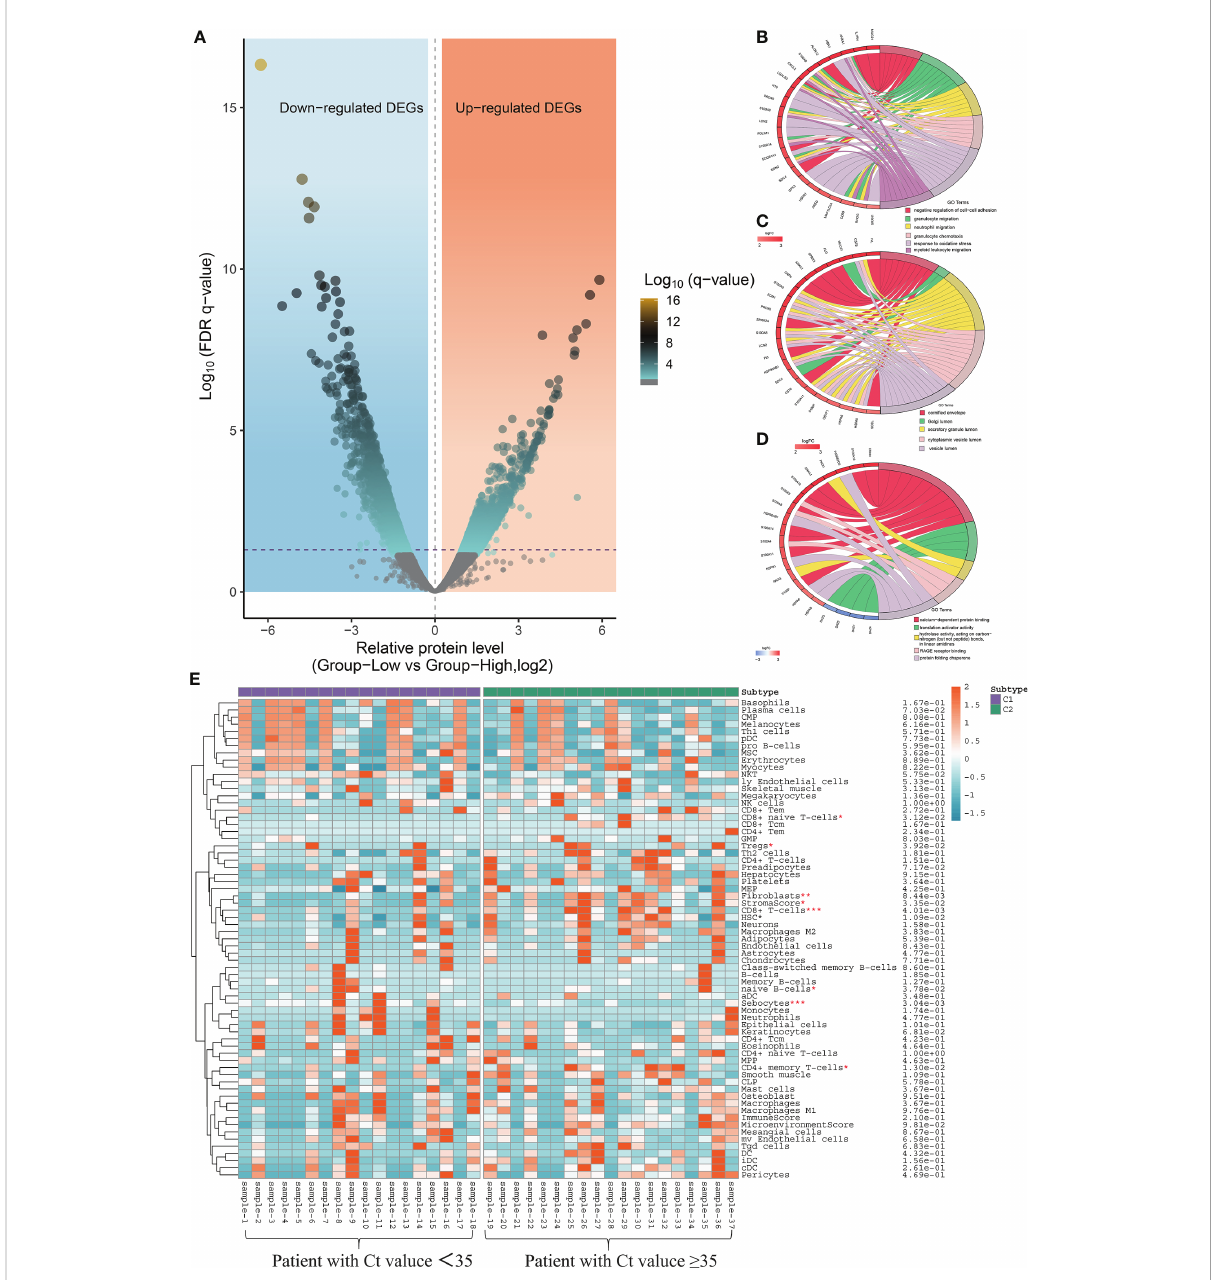
FIGURE 7 Local nasopharyngeal immune microenvironment analysis between high and low virus load patients. (A) Differentially expressed genes (DEG) by volcano diagram. (B) Functional enrichment analysis of the biological process (BP) (C) Functional enrichment analysis of cellular component (CC). (D) Functional enrichment analysis of molecular function (MF). (E) xCell immune score identi fi es the difference in abundance scores of 64 immune cell types between patients with high and low viral